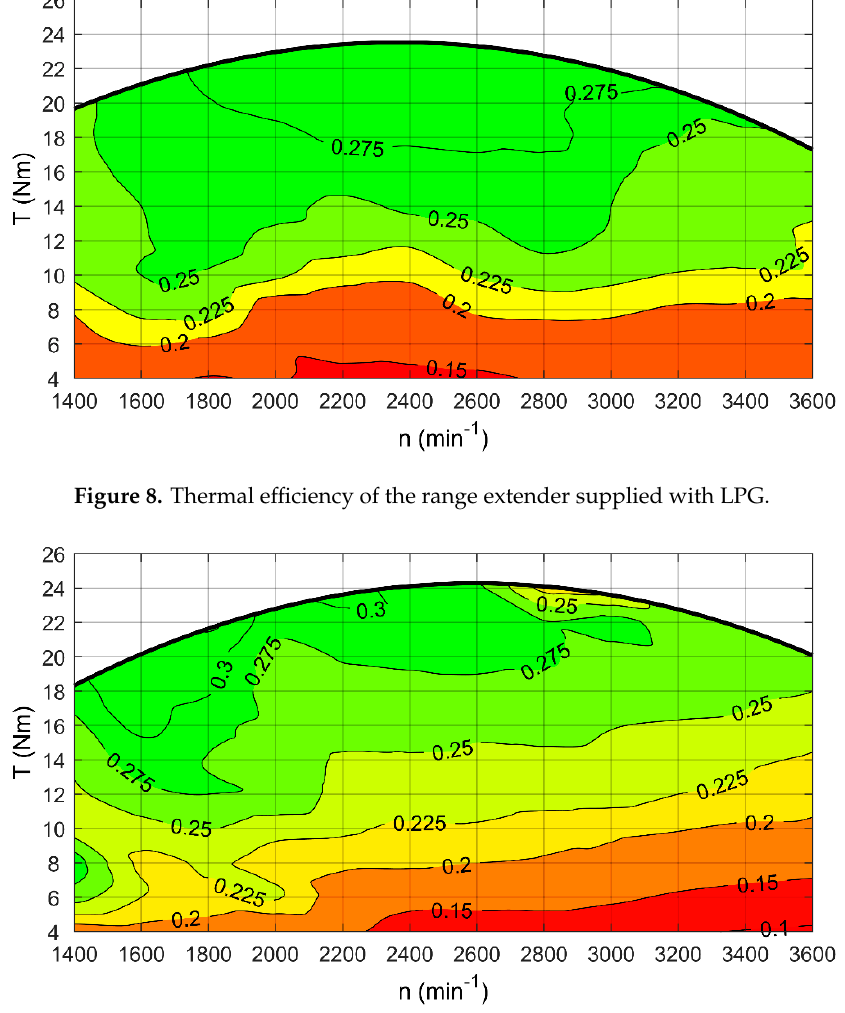
ffi ciency of the range extender supplied with Figure 9. Thermal efficiency of the range extender supplied with gasoline. Figure 9. Thermal e Figure 9. Thermal efficiency of the range extender supplied with gasoline.